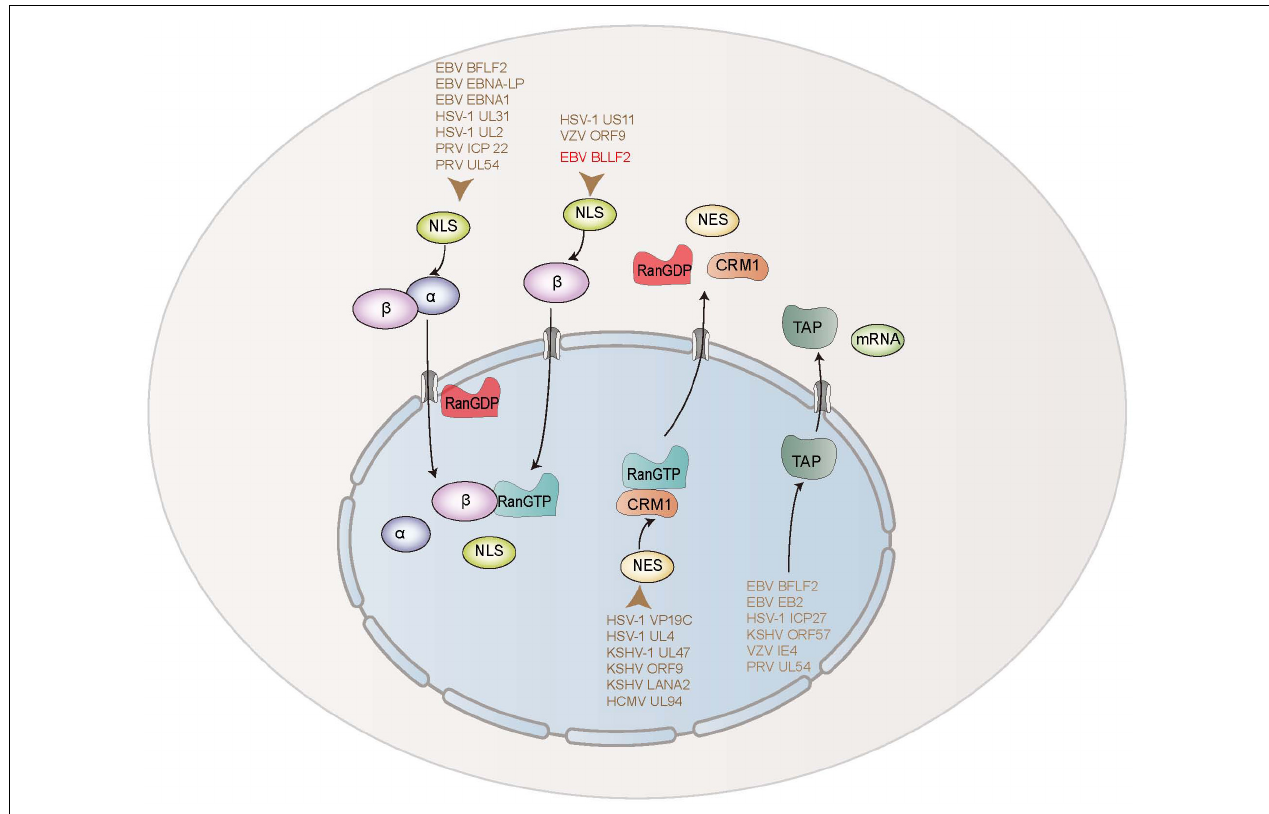
FIGURE 8 | Schematic diagram of nuclear transport mechanisms of EBV and other herpesviruses-encoded